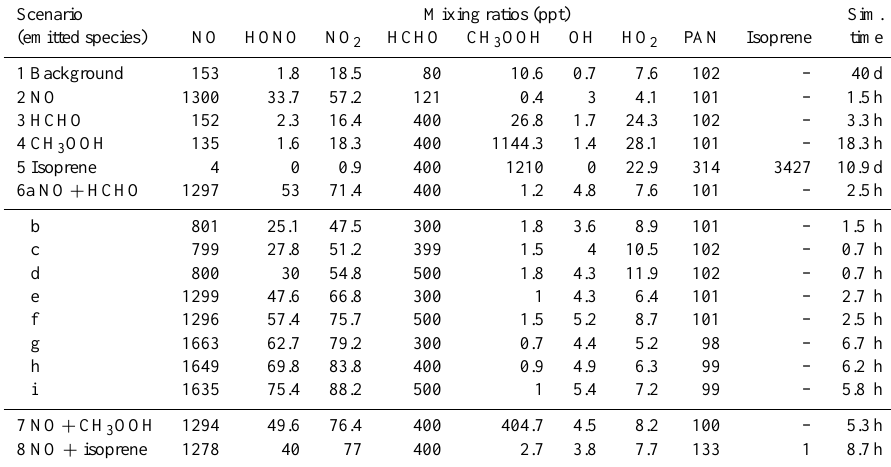
Table 9. Overview of CAABA box model results for the standard emission scenarios listed in Table 8. The mixing ratios are given in ppt (10 − 12 molmol − 1 ). The simulation time (sim. time) is given in days (d) or hours (h) until a (temporary) steady state is reached. The background simulation was running for 40days. Emitting isoprene increases the isoprene mixing ratios unrealistically, not so together with NO